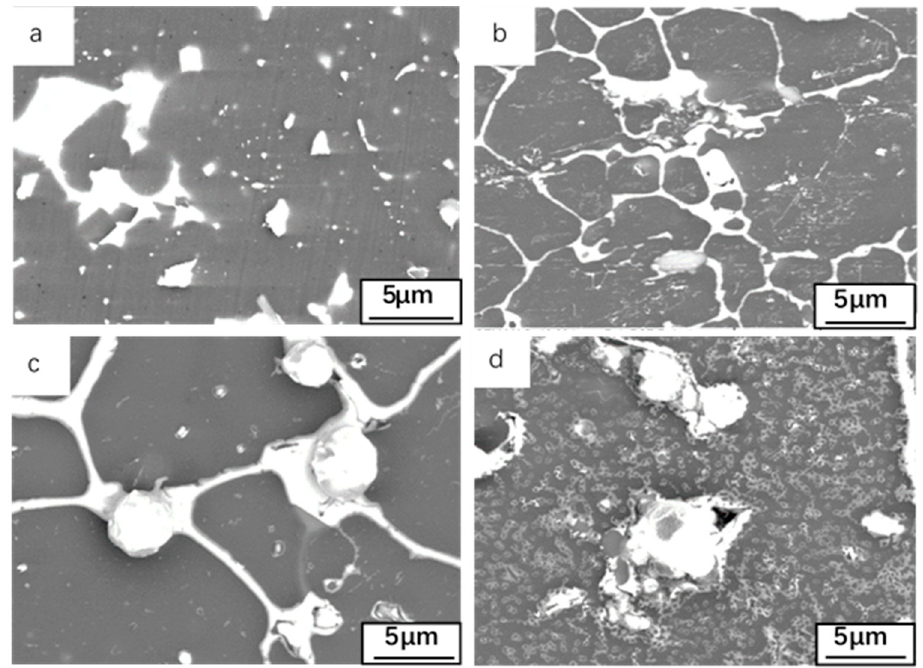
Figure 3. Surface morphologies of oxide films formed after 12 h at different temperatures ( a ) 25 °C, ( b ) 180 °C, ( c ) 300 °C, ( d ) 500 °C. Surface SEM images and EDS map of Al-Sn alloy oxidized for 12 h at 300 °C is shown in Figure 4. Sn precipitates along the grain boundary and channels between α -Al